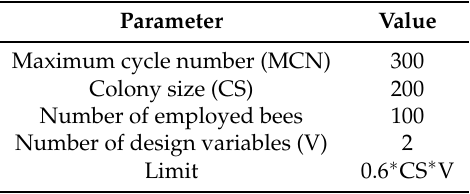
Table 1. ABC algorithm